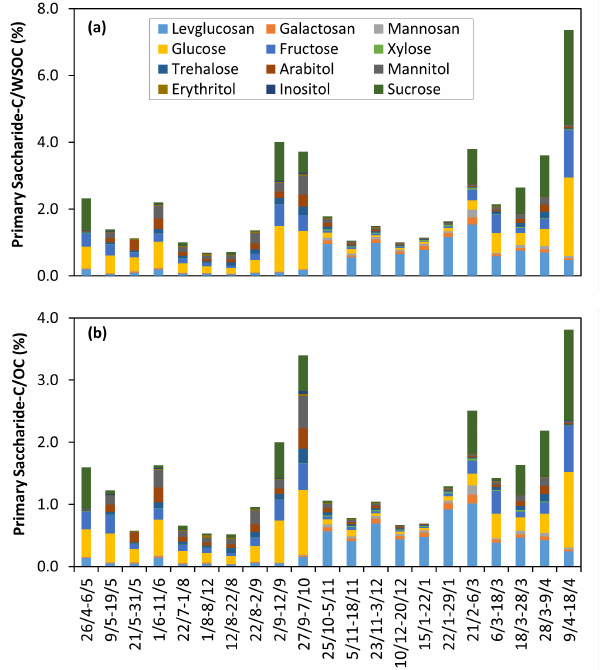
Figure 7. Contribution of primary saccharide C in (a) WSOC (per- cent), and (b) OC (percent) in TSP collected over Gosan during April 2013–April 2014.